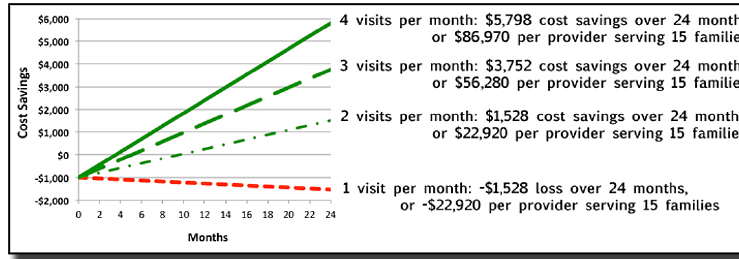
Figure 3. Cost savings for TI when compared to In-person home